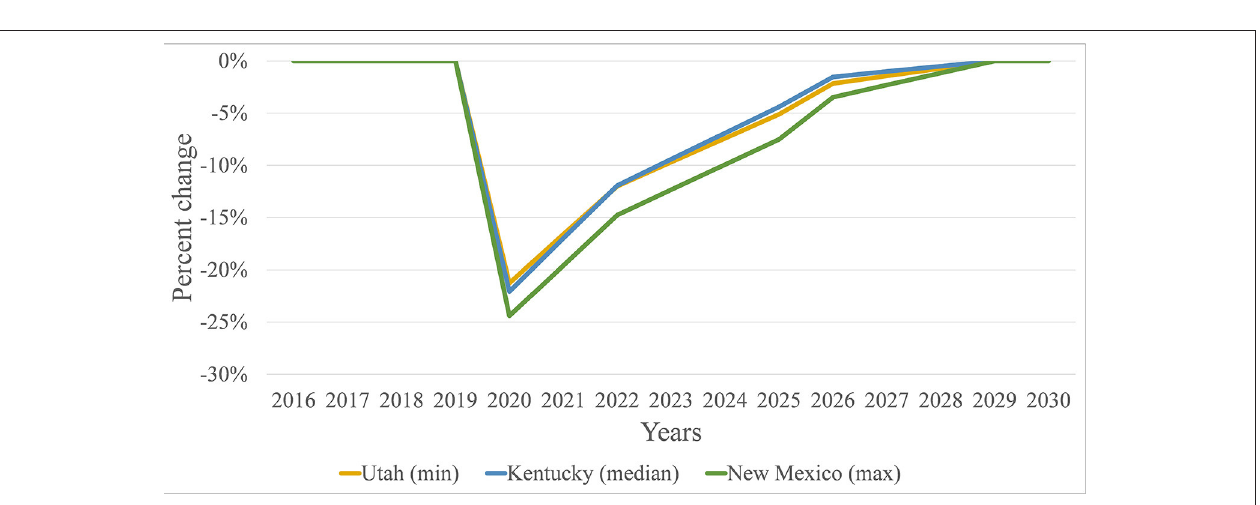
via contaminated urine or feces from infected animals, the novel disease has been transmitted from wildlife to farmed cows in the U.S. In this scenario imported beef remains